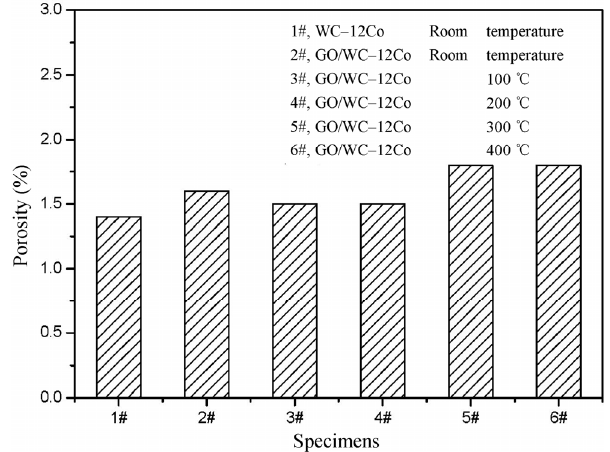
Fig. 8 Microhardness values of the coatings prepared via different heat treatment